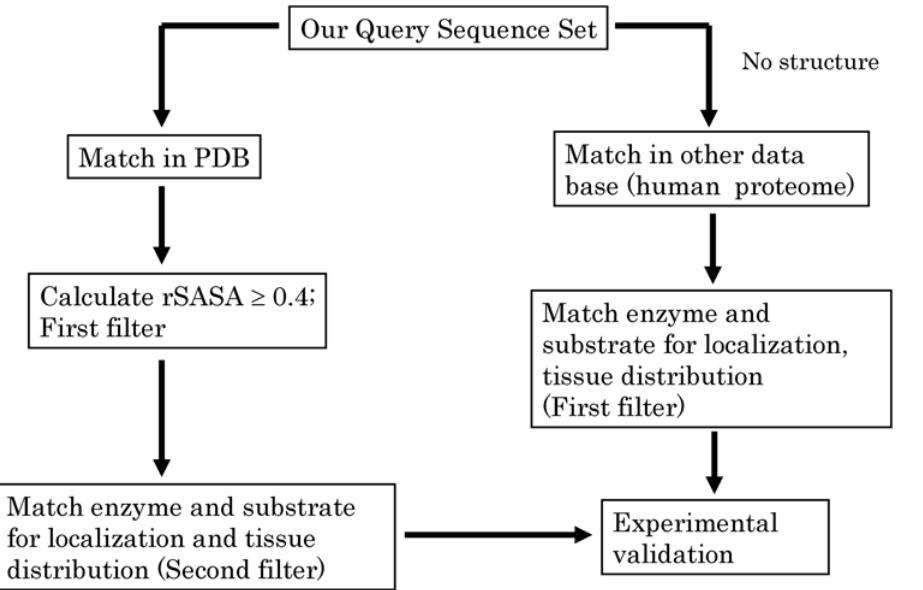
Figure 6. Flow chart of the method. A schematic of our method for in silico screening of natural substrates of proteases is presented. If no structure is available, colocalization can be used as the filter to identify putative substrates especially with the octapeptide as the QSS. Eventually however experimental validation is inevitable.